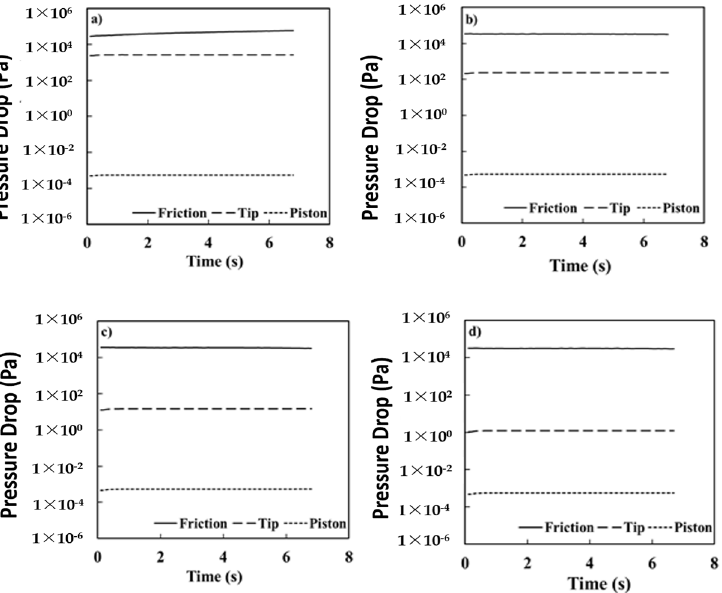
Figure 5. The pressure drop for friction, piston, and tip, for air piston head press at 3.3 × 10 − 3 m/s with various tip sizes; ( a ) 1.1 × 10 − 4 m; ( b ) 2.0 × 10 − 4 m; ( c ) 4.0 × 10 − 4 m; ( d ) 7.5 × 10 − 4 m.